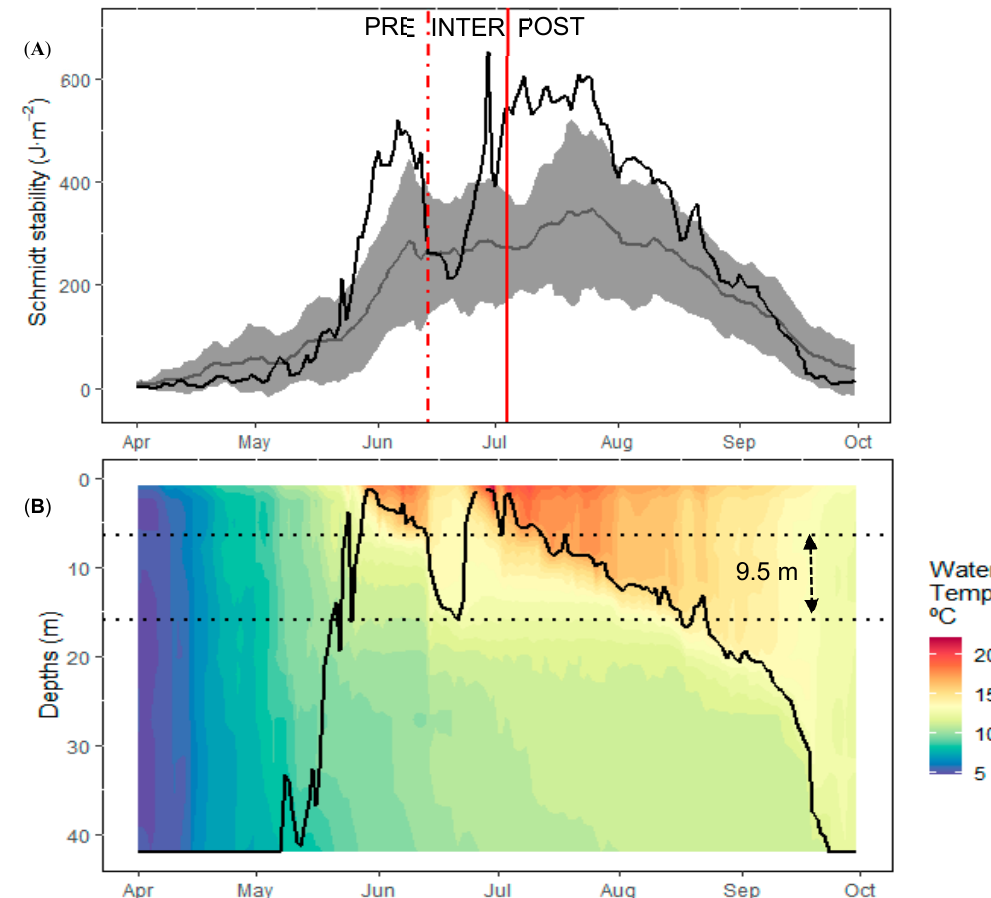
Figure 3. ( A ) Schmidt stability (J · m − 2 ) of Lough Feeagh. Black line indicates 2018 values. The mean ± SD for the 2004–2018 period is shown by the grey line and area. The dotted red line indicates the Storm Hector event and the solid red line indicates when the Feeagh water column returned to more stable stratification conditions, highlighting pre-, intermediate and post-storm periods. ( B ) Temperature contour plot of Lough Feeagh water column. Black line indicates 2018 estimated mixed layer depth (m) daily values. Dotted black lines highlight the 9.5 m mixed surface layer deepening during the intermediate period.